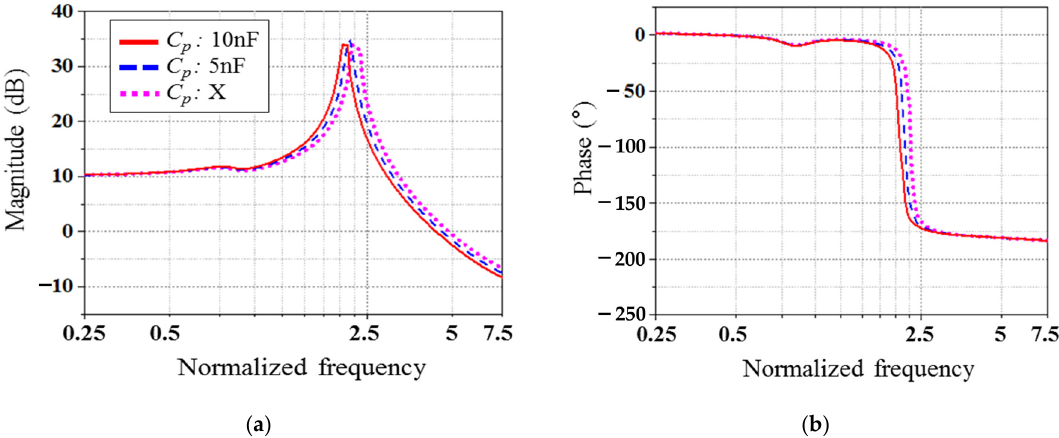
Figure 5. The transfer function characteristics of the designed filter, including the matching circuit and BVD: ( a ) the magnitude; ( b ) the phase.